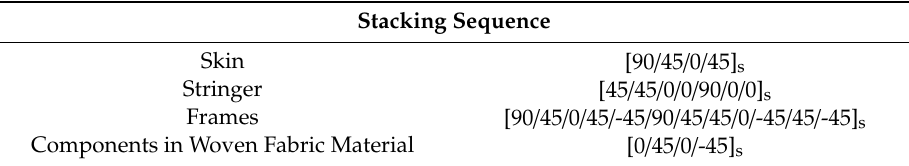
Table 5. Sub-components stacking sequences.